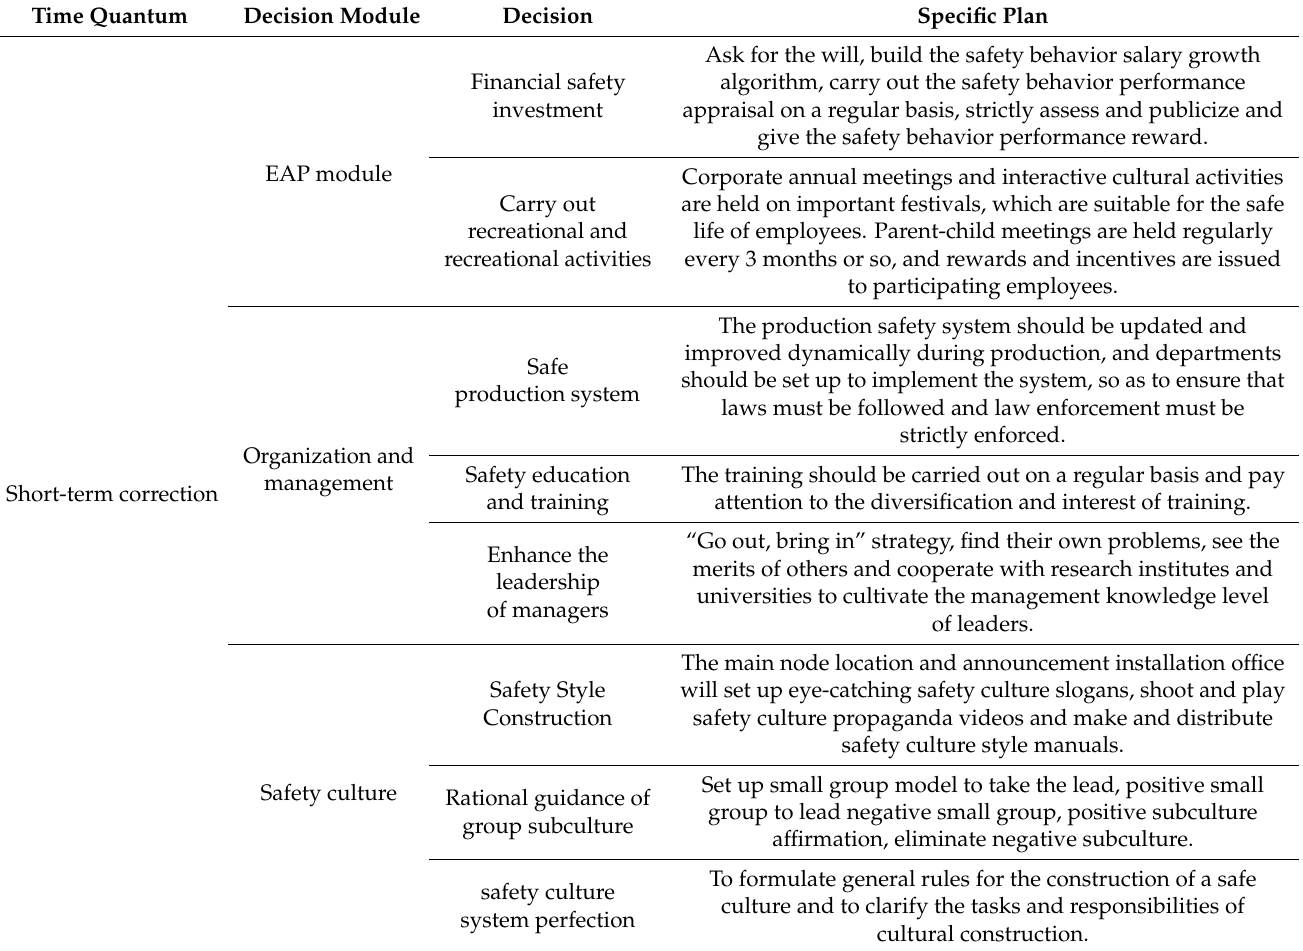
Table 3. Operation mechanism and specific implementing scheme of correction